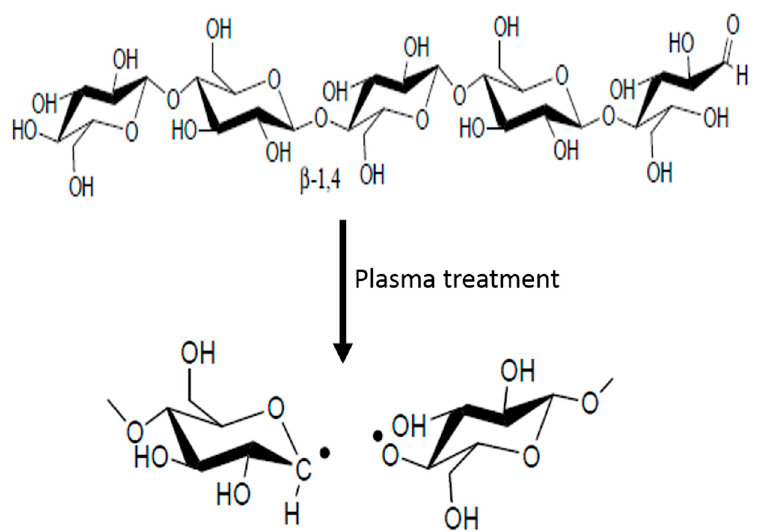
Figure 1. Formation of free carbon and oxygen radicals after cotton plasma treatment.